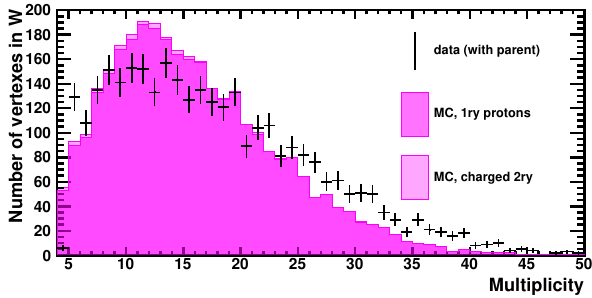
Figure 18 . Measured multiplicity of charged particles at the proton interaction vertices compared with the prediction from FLUKA